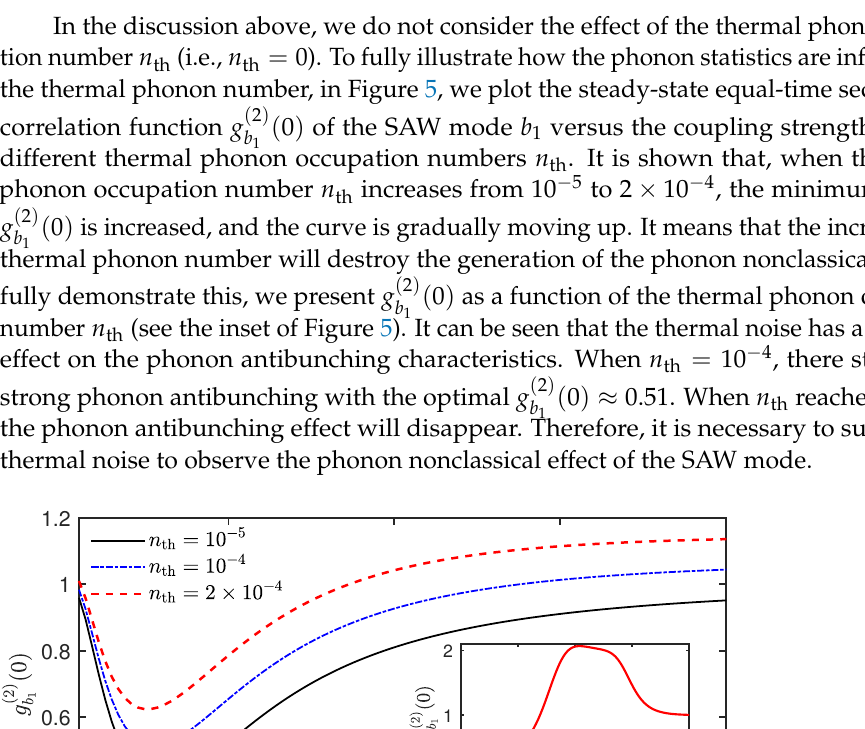
Figure 4. ( a ) Steady-state equal-time second-order correlation function g versus the coupling strength g / κ with different driving strengths ε b case ∆ = 0; ( b ) steady-state equal-time second-order correlation function g ( 2 ) ( 0 ) of modes α , β , and b 1 versus the mechanical driving detuning ∆ / κ . The system parameters are the same as in Figure 2 except for ( b ) g = 0.3 κ .